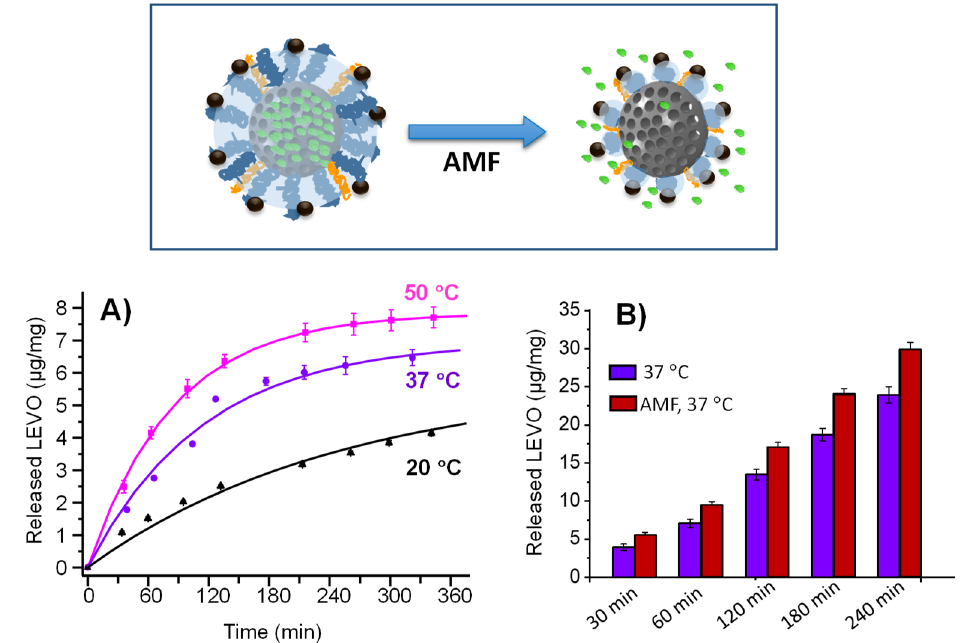
Figure 5. ( A ) LEVO release profile at different temperatures: 20, 37 and 50 ◦ C. ( B ) Total LEVO release at different times at 37 ◦ C (blue bars) and same conditions plus magnetic field exposition (red bars). Data are mean ± SD of the three replicas. The different conditions used during both experiments are detailed in Section 2.3.2.